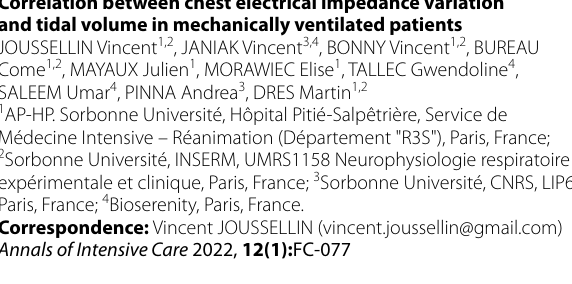
Figure 1. ROC curves for the prediction of late ARF worsening at D15 in the derivation and validation cohorts. A) ROC curves were computerized in derivation and validation cohorts for the CERES score (black plain line), for the top 2 predictive